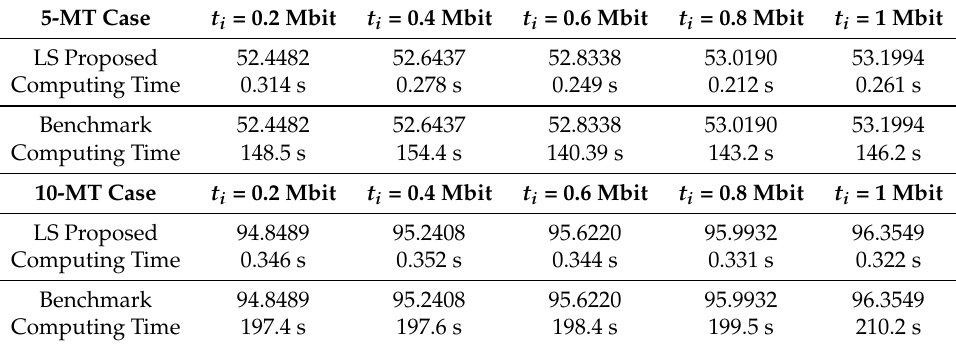
Table 2. Performance of our proposed algorithm.